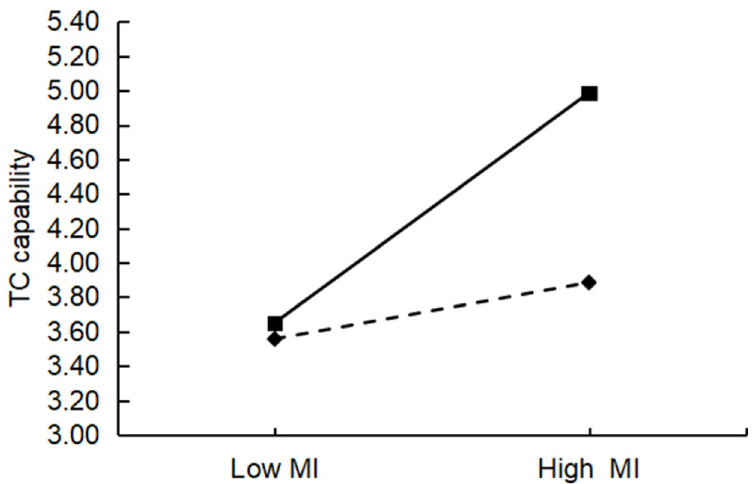
Fig 6. Test of the moderating effect of absorptive capacity differences on management interaction and TC capabilities.